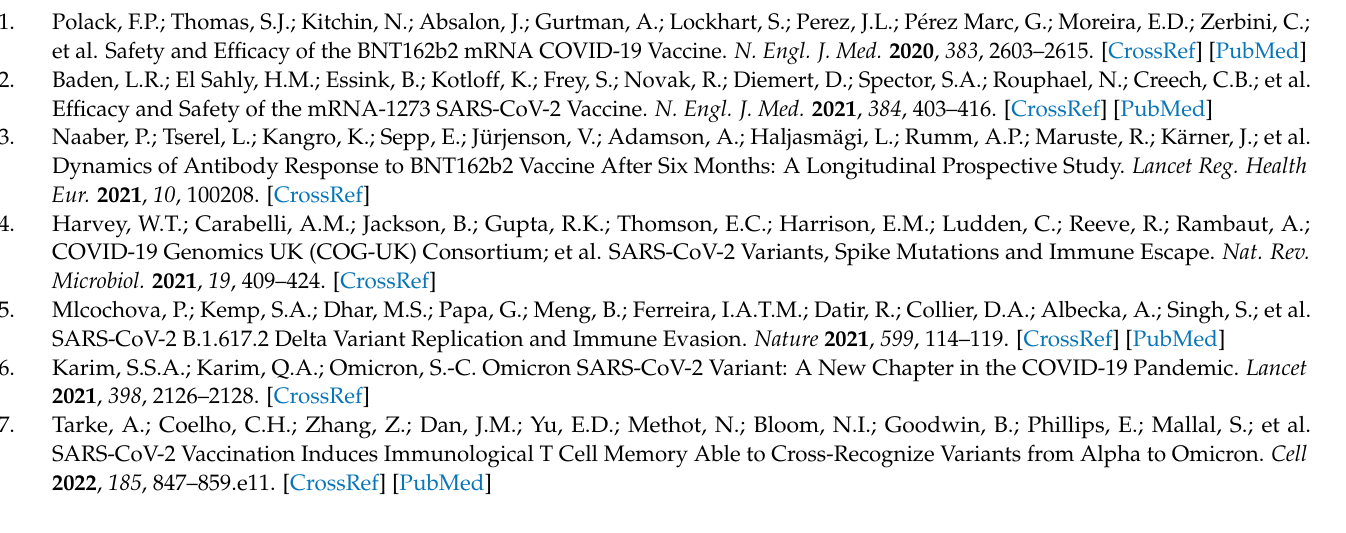
Table S3. Association between neutralizing antibodies at two weeks after the booster dose and the delta from the peak of immune parameters after the second dose. Figure S1. A one-year time course of the humoral and cell-mediated immunity against SARS-CoV-2 with three doses of the BNT162b2 vaccine in all of the study subjects, classified by gender and age; Figure S2. Correlation at time points between T-SPOT and anti-RBD total Ig after the BNT162b2 vaccine; Figure S3. Correlation at time points between T-SPOT and anti-RBD IgG after BNT162b2 vaccine; Figure S4. Correlation at time points between T-SPOT and neutralizing antibodies after BNT162b2